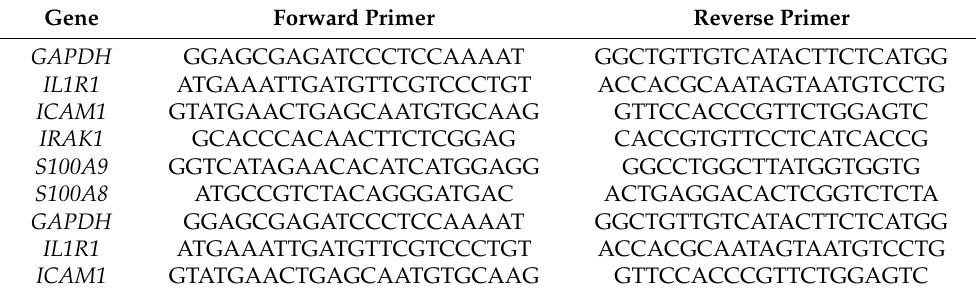
Table 2. Primers used for qPCR